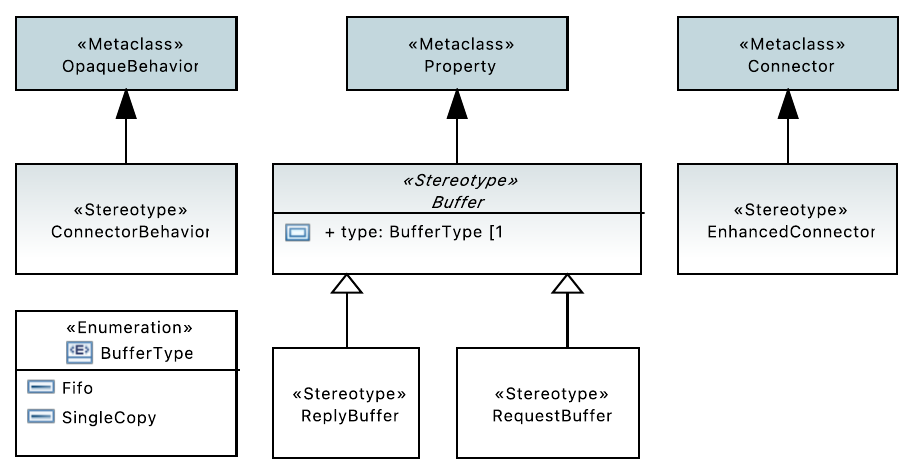
Figure 9. Enhanced connector